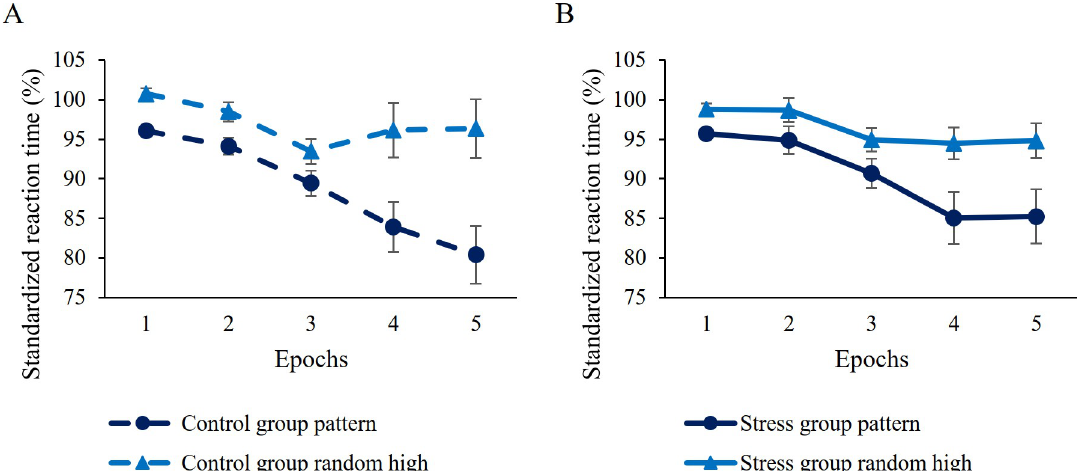
Fig 5. Learning of serial-order regularities in (A) control and (B) the stress groups. Dashed lines represent the control group, continuous lines represent the stress group. Dark blue lines with circle symbols indicate standardized reaction times on pattern trials, blue lines with triangle symbols indicate standardized reaction times on random high trials. Learning of serial-order regularities is quantified by the distance between dashed and continuous lines, greater distance represents better learning. Error bars denote the SEM.